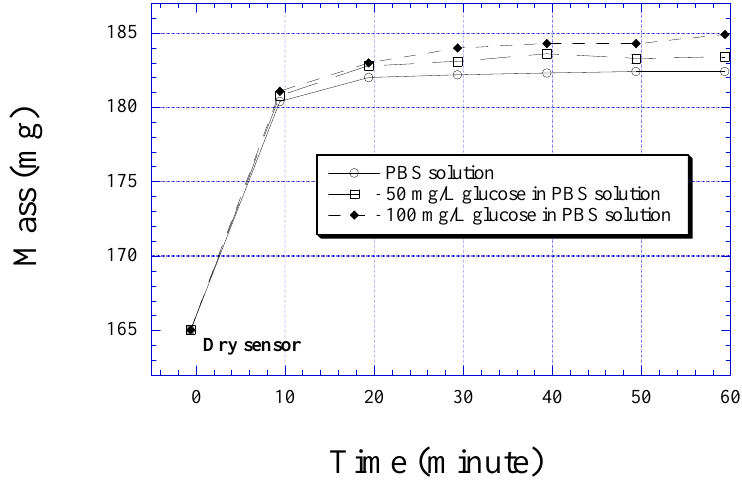
Figure 3. Mass change of a 12 µm thick glucose responding polymer layer as it is immersed into phosphate buffered saline solution with and without